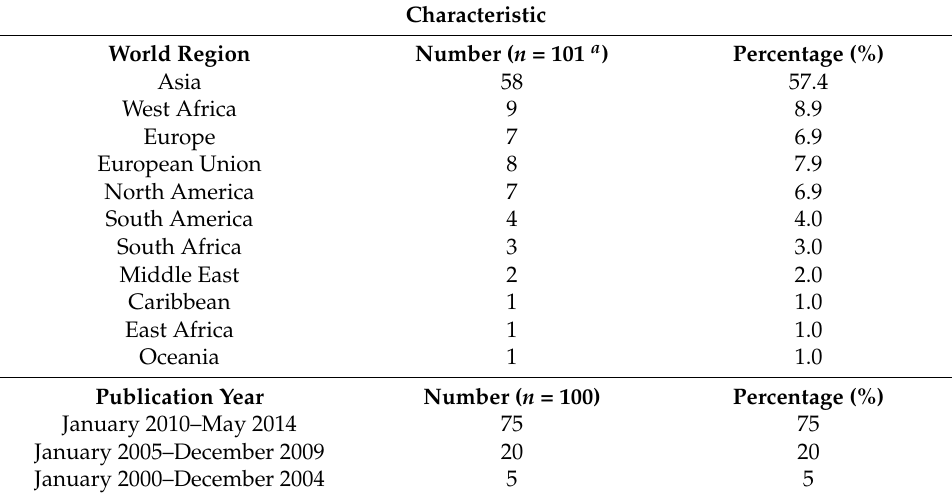
Table 3. Literature characteristics from scoping review ( n =